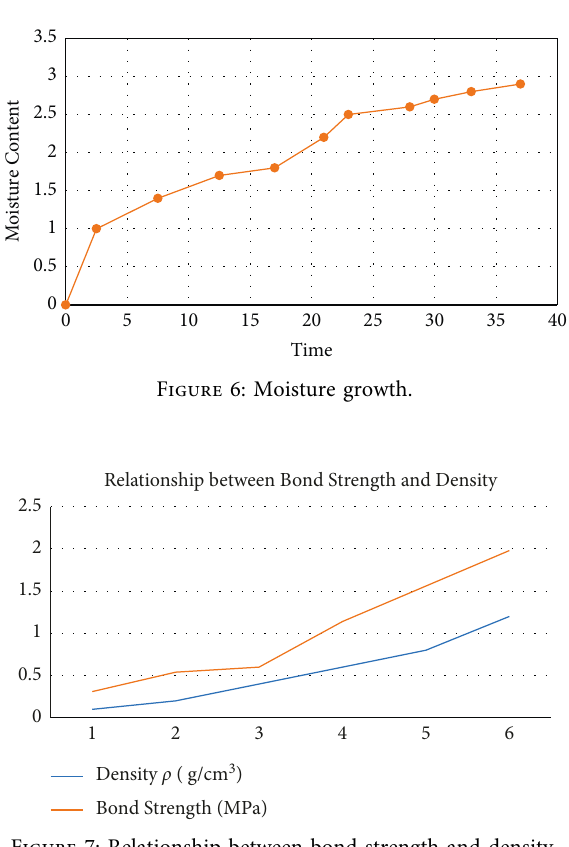
Figure 8: Test sample.